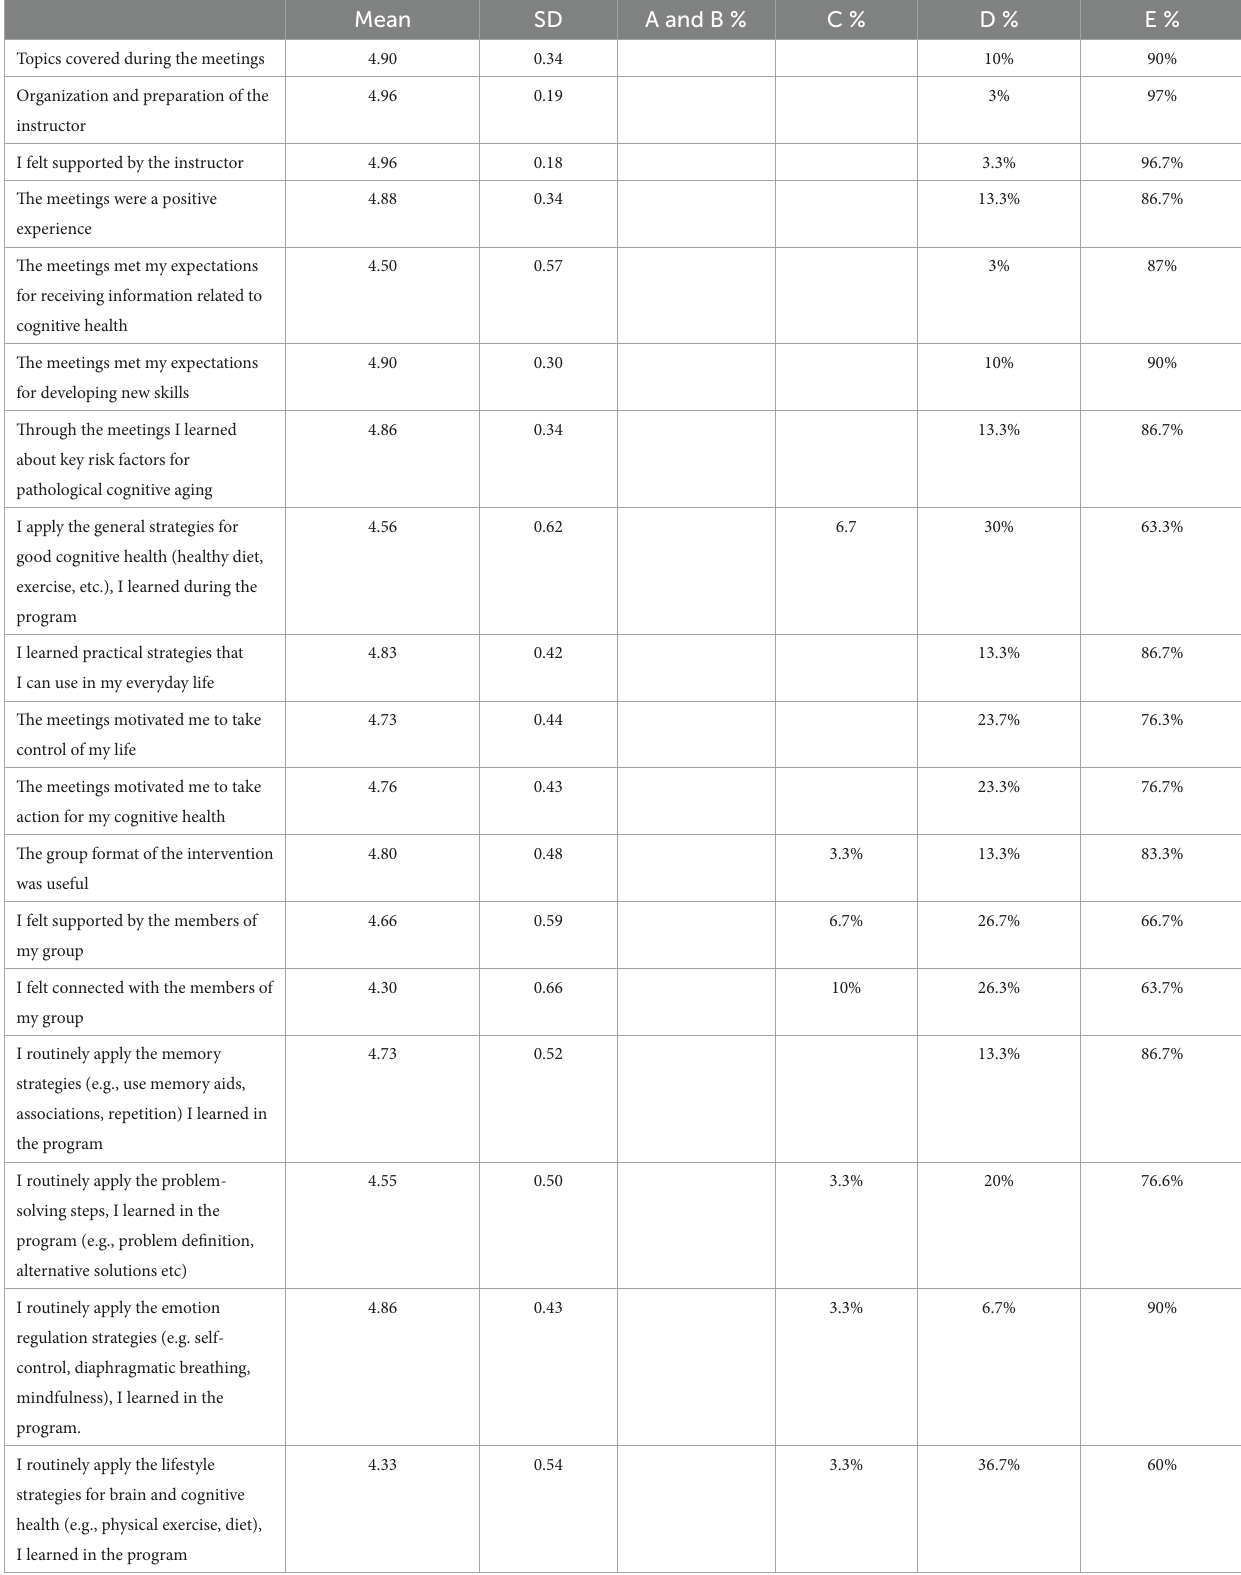
TABLE 2 Means, standard deviations, and percentages for the participant satisfaction scale. Mean SD A and B % C % D % E